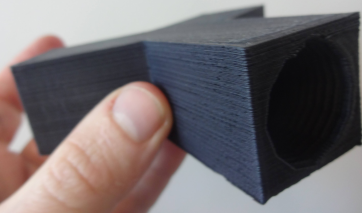
Figure 14. 3-D printable garden hose